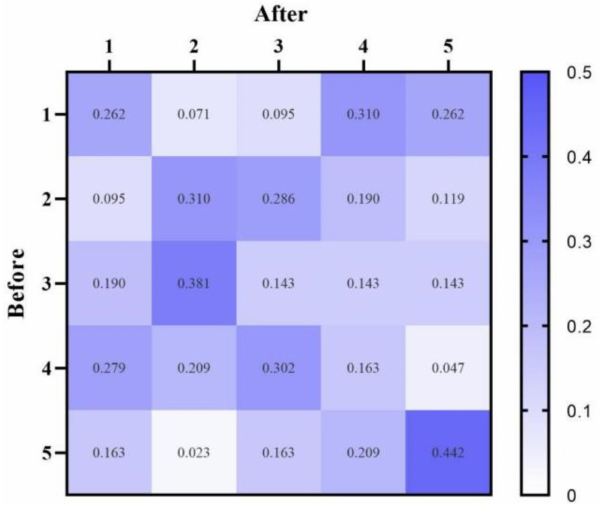
Figure 7. Mobility matrix of livelihood capital. (Numbers 1–5 represent different levels of livelihood capital: 1: low; 2: medium-low; 3: medium, 4: medium-high; 5: